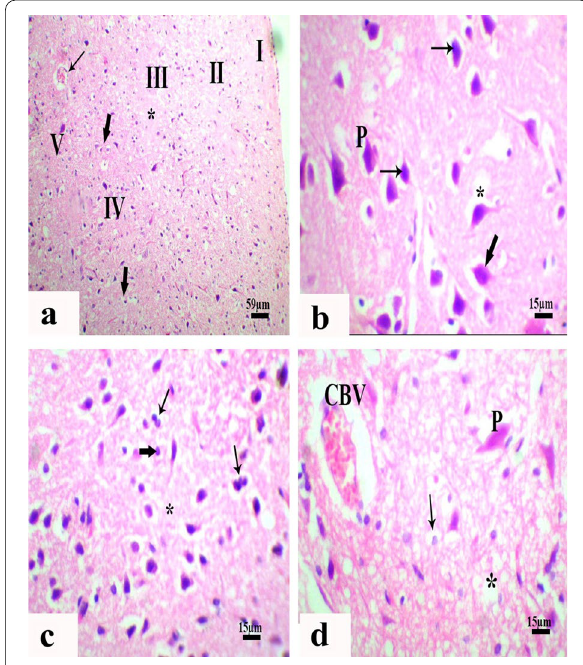
Fig.4 photomicrographs of sections of the cerebral cortex obtained from paroxetine-treated rats showing a : disorganization of cerebral cortex layers I, II, III, IV, and V, degenerative vacuolization (thick arrows), and congested blood vessel (thin arrow). b : showing eosinophilic degeneration of pyramidal cells (P), loss of its cell processes, eosiniphilic cytoplasm (thick arrow) and small dark nuclei (thin arrow), and some cells surrounded by halos (*). c : layer IV contains multinuclear of granule cells (thin arrows), neurons with pyknotic nuclei (thick arrow) and intercellular edema (*). d : degenerative granular layer contains vacuolated granule cells with pyknotic nuclei (arrow), eosinophilic pyramidal cells (P), degenerated neuropil (*) and congested blood vessel Electron microscopic examination of the cerebral cor- tex of reserpine-treated rats showed obvious degenera- tive changes. The pyramidal cells with dark, shrunken irregular nuclei had a small amount of peripheral chro- matin, and irregularities of nuclear envelopes were observed. The cytoplasm of these cells showed many degenerated features included electron-lucent vacu- oles, scanty free ribosomes, lysosomes, disrupted mito- chondria, and dilated rough endoplasmic reticulum (Fig. 7a–c). The apoptotic pyramidal cells had cyto- plasmic blebs, shrinkage or intended oval nuclei with chromatin condensation or margination, and clump- ing, of electron dense heterochromatin and irregular- ity of nuclear envelope (Fig. 7d, e). The granule cells in the same group appeared either degenerated or apop- totic showing severe ultrastructure changes include, shrinkage of the rounded nuclei with chromatin con- densation; margination and clumping of its electron dense heterochromatin. Their cytoplasm contained